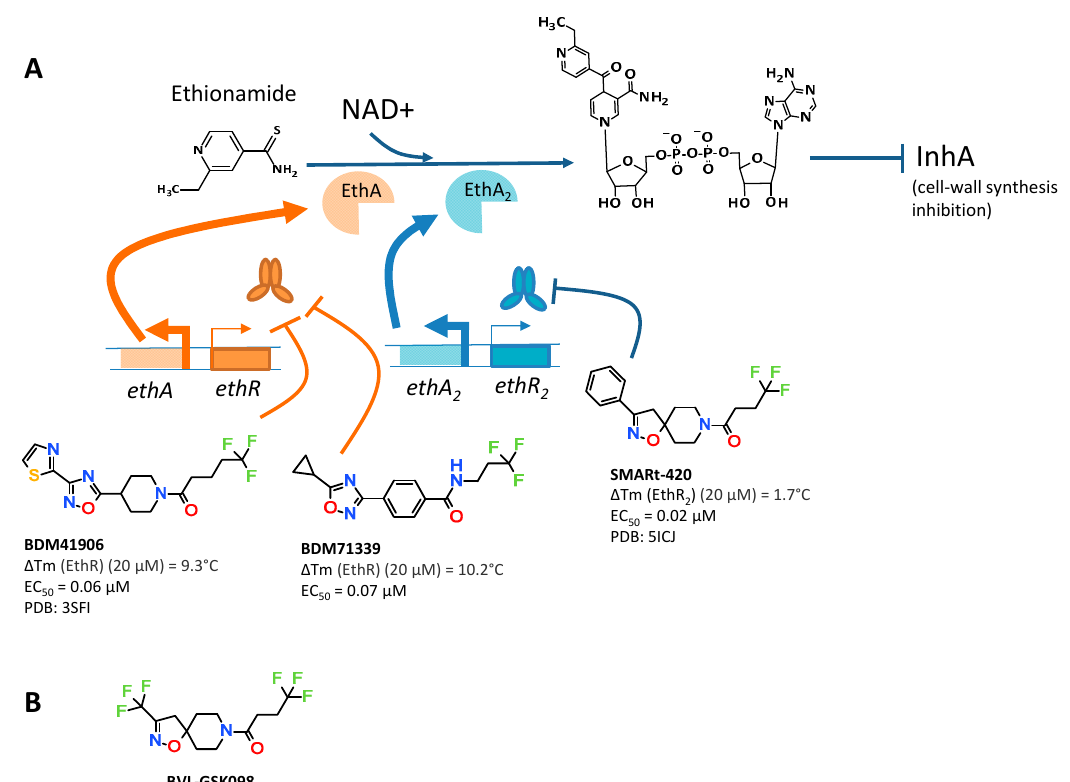
Figure 1. ( A ) Ethionamide bioactivation pathways: EthA and EthA2 are triggered by the inhibition of mycobacterial transcription factors EthR and EthR 2 with small molecules BDM41906, BDM71339, and SMARt-420; ( B ) structure of the clinical candidate BVL-GSK098.